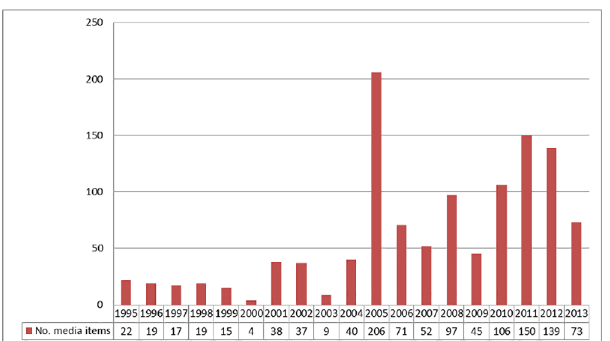
Fig 1. Number of news items about nonsmoker-only hiring policies, by year: United States, 1995 – 2013 (n = 1,159)